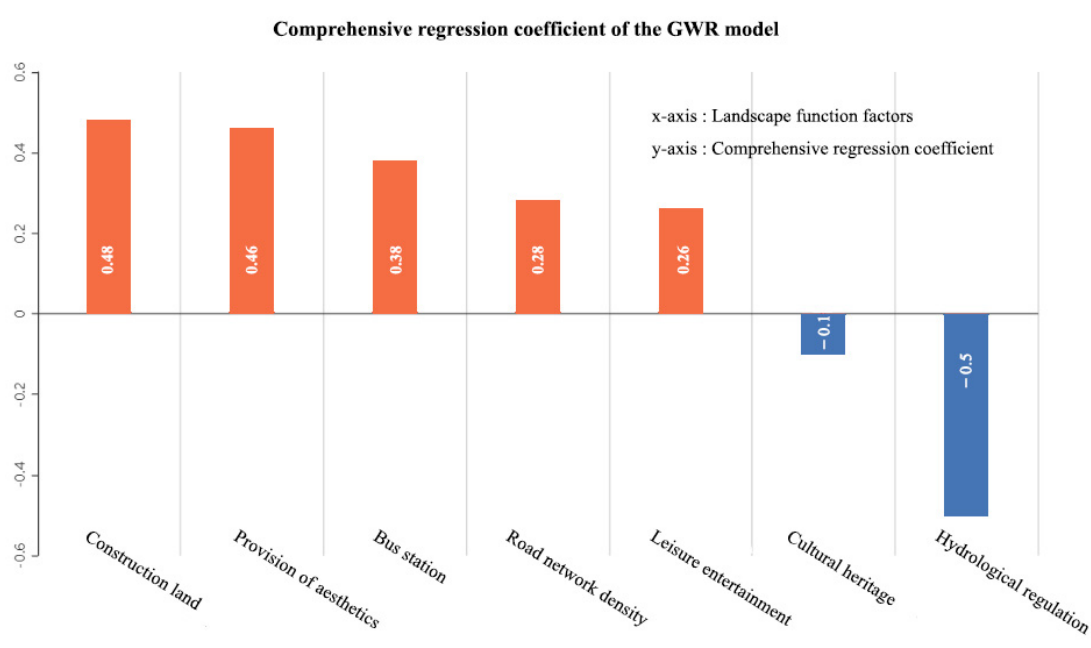
Figure 6. Comprehensive regression coefficient of LF factors of the GWR model.